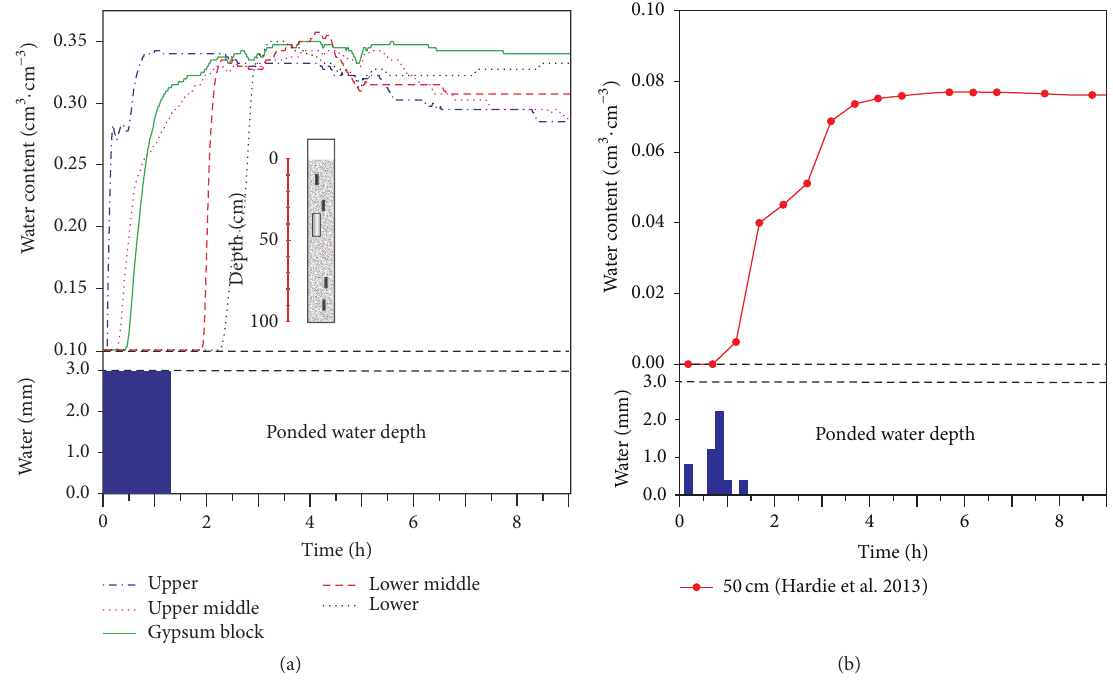
Figure 6: Comparison of wetting front progression versus time as derived from (a) second infiltration test of this study measured by electrical resistance sensors and (b) modified from Hardie et al. [19]. The ponded water depth at the upper boundary is also